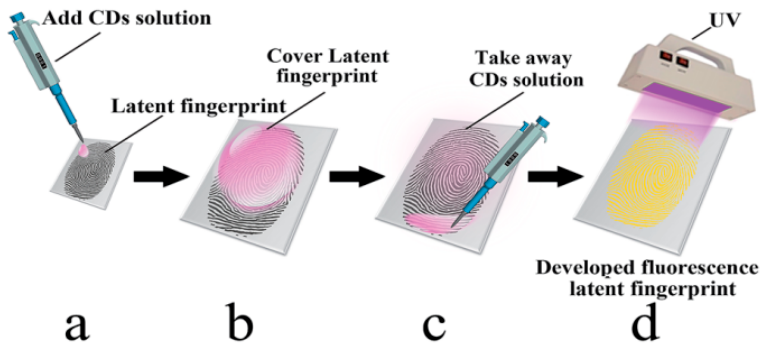
Figure 6. The fingerprint development process: the C-dot solution is added to the fingerprint ( a ), covering it completely ( b ); the solution is then removed by pipette ( c ) and visualised under UV light ( d ). Reproduced from reference [48] with permission from The Royal Society of